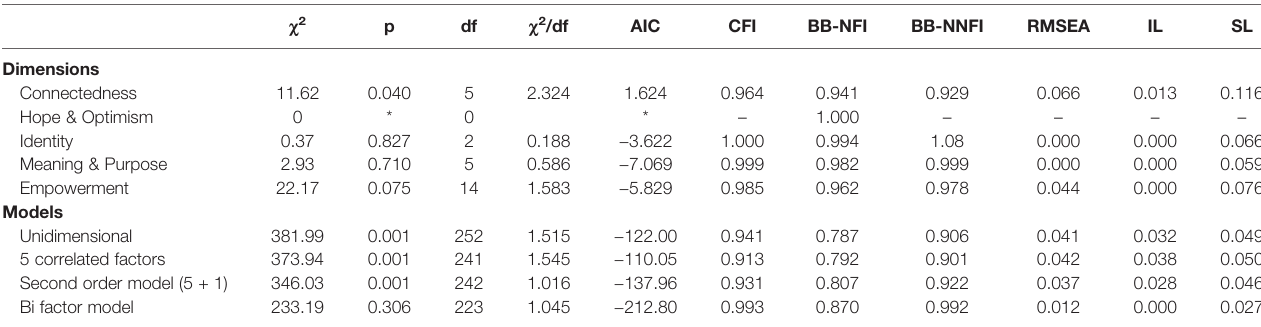
TABLE 3 | Structural